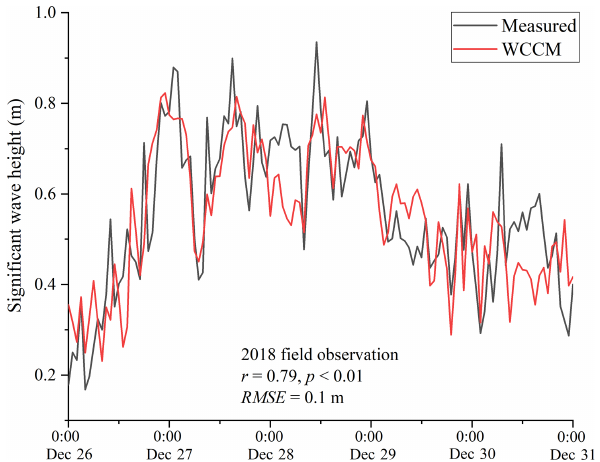
Figure B1. Correlation coefficient (r) and mean absolute error (RMSE) between measured and WCCM-simulated significant wave height at the LHWS during the 2018 field observation.